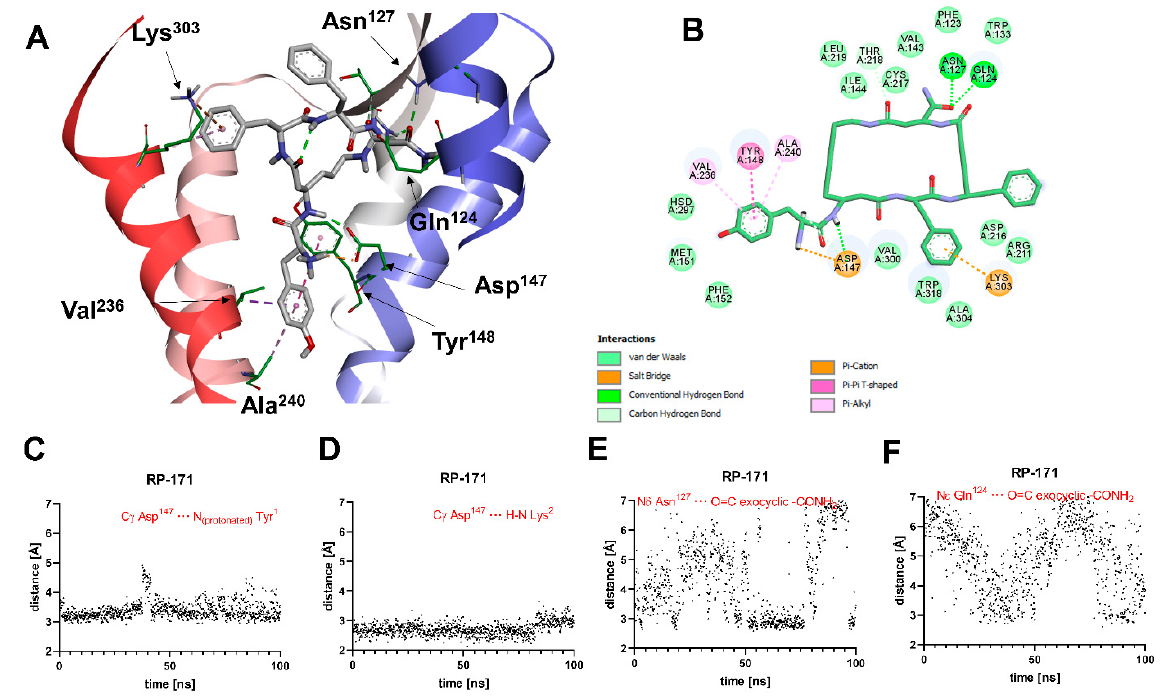
Figure 4. ( A ) Binding mode of RP-171 (white sticks) in the MOR binding site, as found at t = 100.0 ns of the MD production run. The receptor is shown in a simplified manner, with only selected helices (ribbons) and side chains (thin sticks) shown. Display of nonpolar hydrogens is suppressed for clarity. ( B ) Diagram showing interactions between RP-171 and the MOR binding site (interaction types colored according to the legend). ( C – F ) Time evolutions of selected distances associated with protein–ligand interactions during the MD simulations .